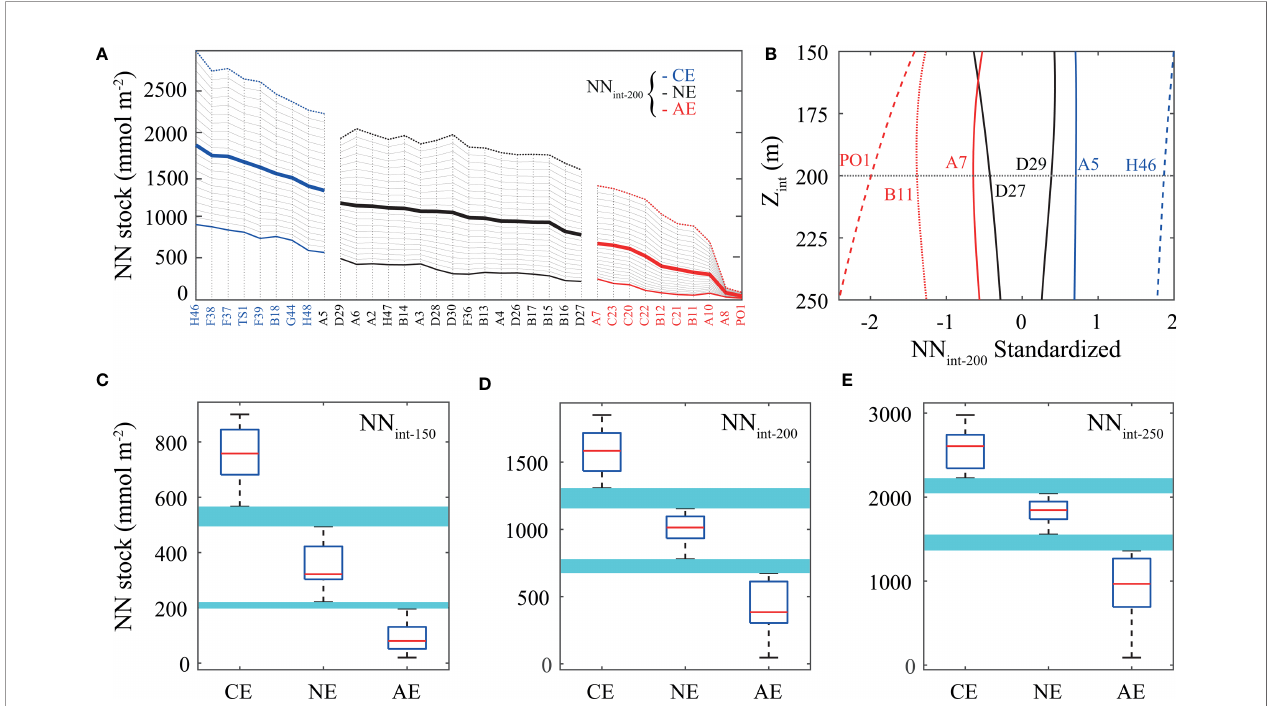
FIGURE 3 | (A) Nitrate + nitrite (NN) integrated in the depth intervals of 15 – 150, 15 – 155, and so on up to 15 – 250 m with stations ranked according to NN int-200 (NN integrated between surface and 200 m, mmol m -2 ). The uppermost and lowermost lines correspond to NN int-250 and NN int-150 , respectively, while the thicker, colored lines correspond to NN int-200 . (B) Standardized NN int-z for stations located within the group classi fi cation limits for the same integration intervals as in (A) . Z int indicates the upper depth limit of the NN integral. The blue, black, and red lines correspond to the cyclonic (CE), no eddy (NE), and anticyclonic (AE) groups, respectively. The red dotted line indicates the boundary between the AE and Poseidon stations, while the blue and red dashed lines correspond to the stations H46 and PO1, respectively. Box plots of (C) NN int-150 (mmol m -2 ), (D) NN int-200 (mmol m -2 ), and (E) NN int-250 (mmol m -2 ) for all sampled stations. The cyan regions correspond to the NN int-z intervals that separate the CE (n = 9), NE (n = 15 – 16), and AE (n = 9 – 10) groups. The red line inside each box is the median of the data. The standardization of NN int-z was done for each depth integration interval using the equation: standardized (NN int-z ) = [NN int-z - mean (NN int-z )]/SD (NN int-z